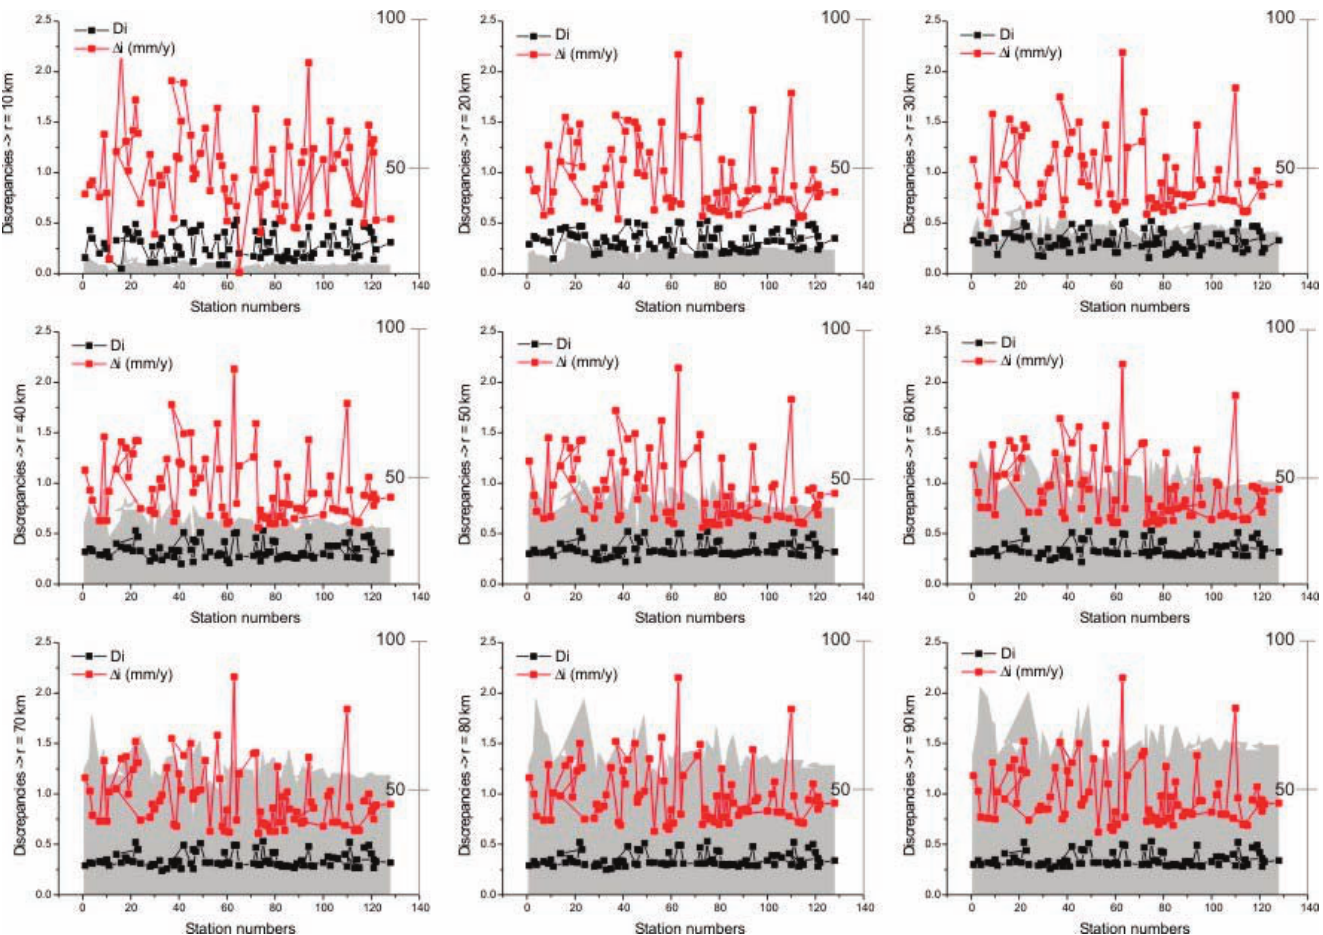
Figure 10. The D